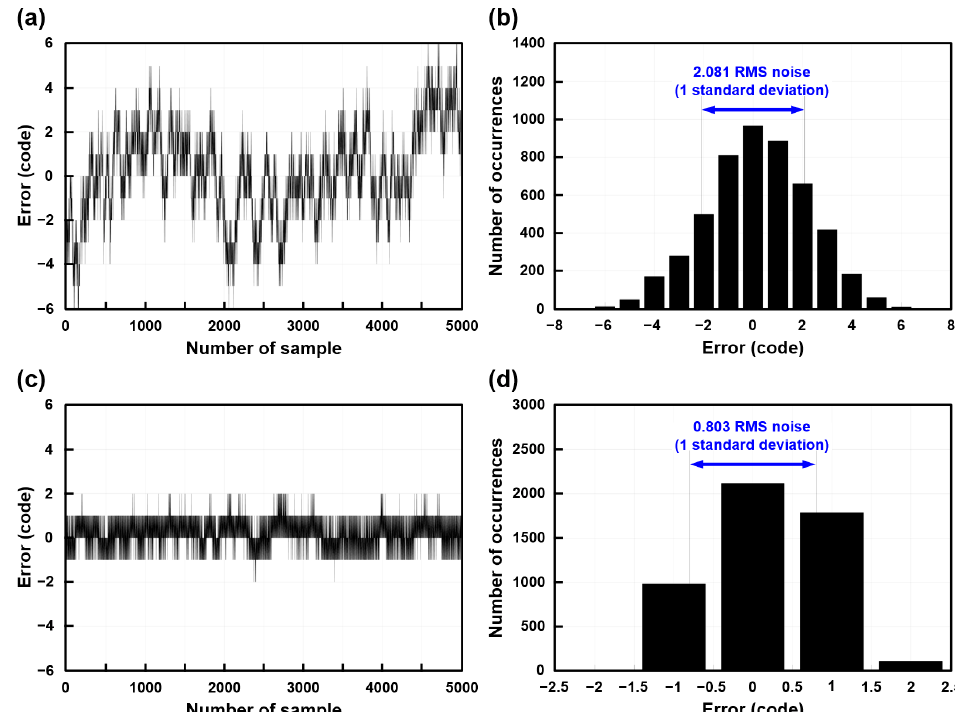
Figure 14. Measured output codes of the proposed reconfigurable sensor analog front-end IC. ( a ) Output code error without chopper stabilization; ( b ) Histogram of output code error without chopper stabilization; ( c ) Output code error with chopper stabilization; ( d ) Histogram of output code error with chopper stabilization.